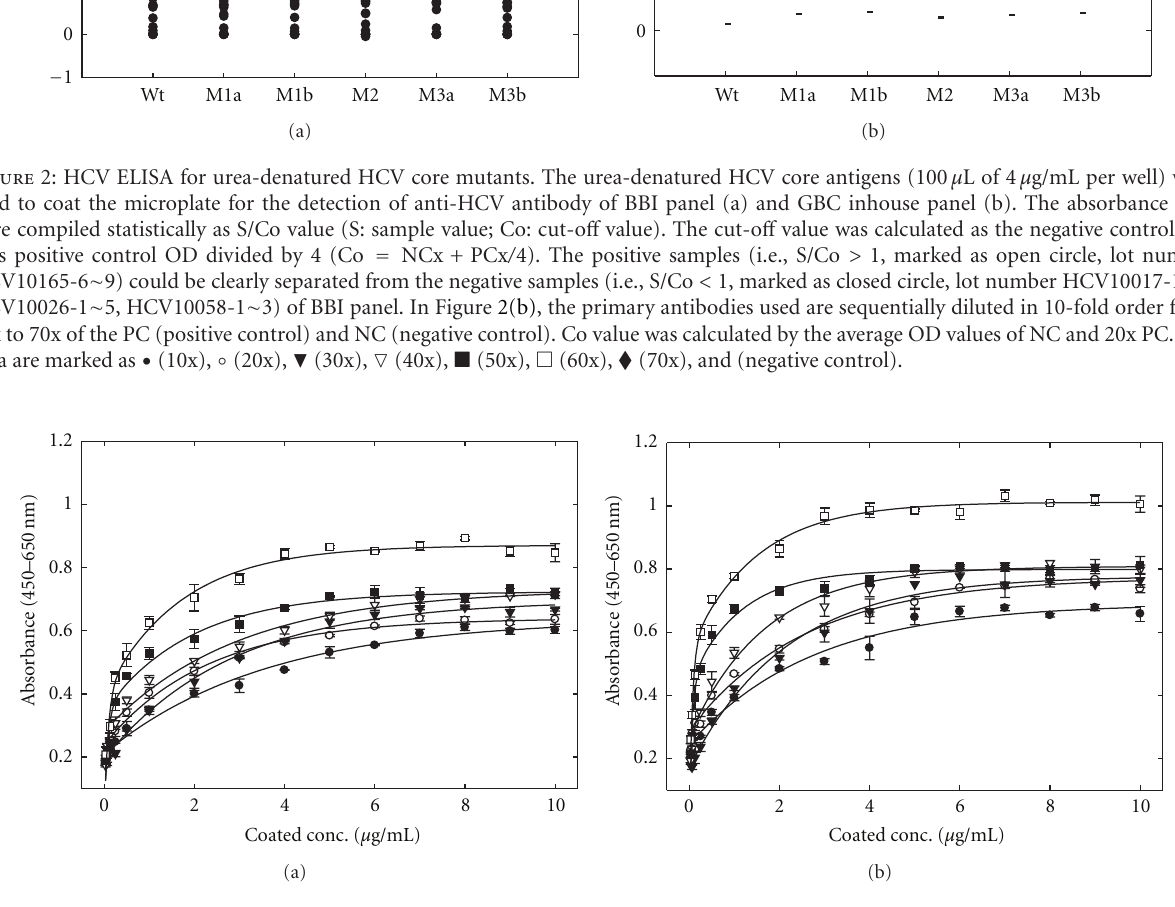
Figure 3: Saturation curves for urea-denatured (a) and refolded (b) forms of HCV core antigens. Antigenicity of unfolded (a) and refolded (b) forms of HCV core antigens were examined by ELISA using the microplate that had been coated with di ff erent amounts of Wt ( • ), M1a ( ◦ ), M1b ( (cid:2) ), M2 ( (cid:3) ), M3a ( (cid:4) ), and M3b( (cid:5)